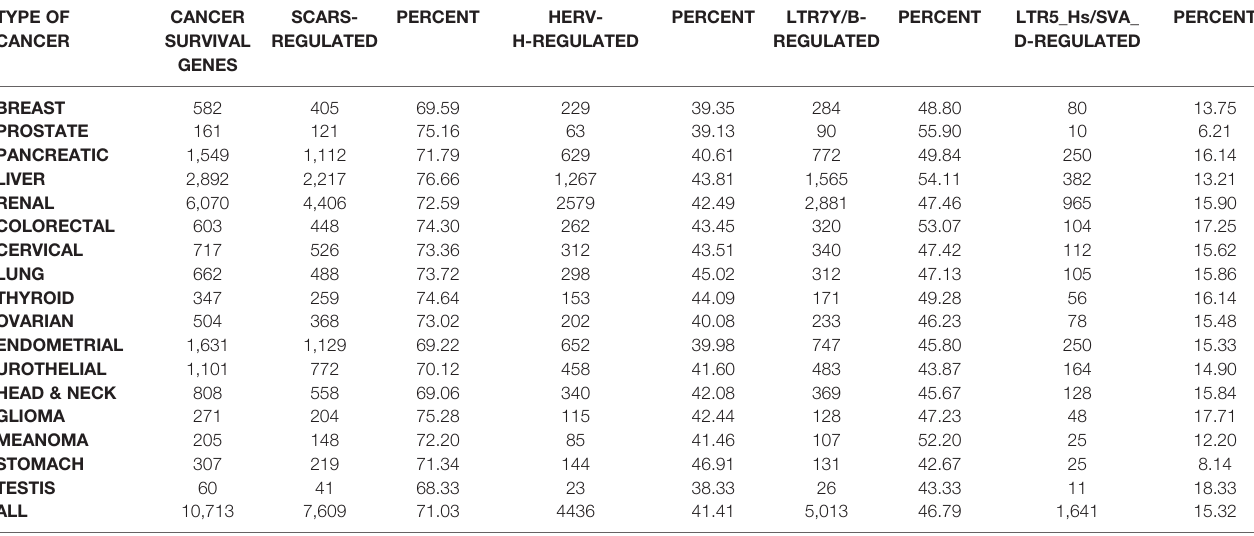
TABLE 4 | SCARS regulate expression of a prominent majority of human cancer survival predictor